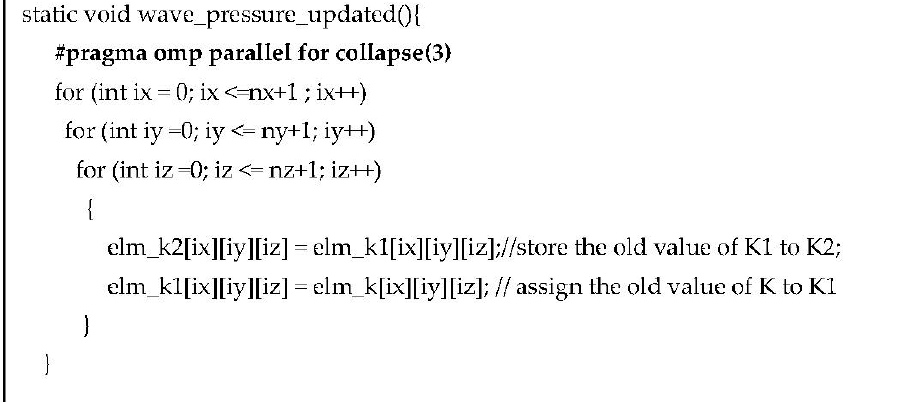
Figure 9. Snapshot of the data swap module.